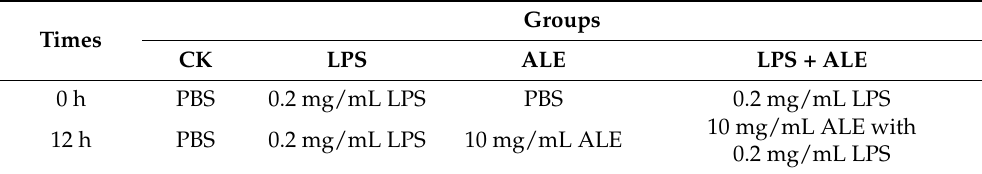
Table 1. Design of inflammatory induction in mice. Times